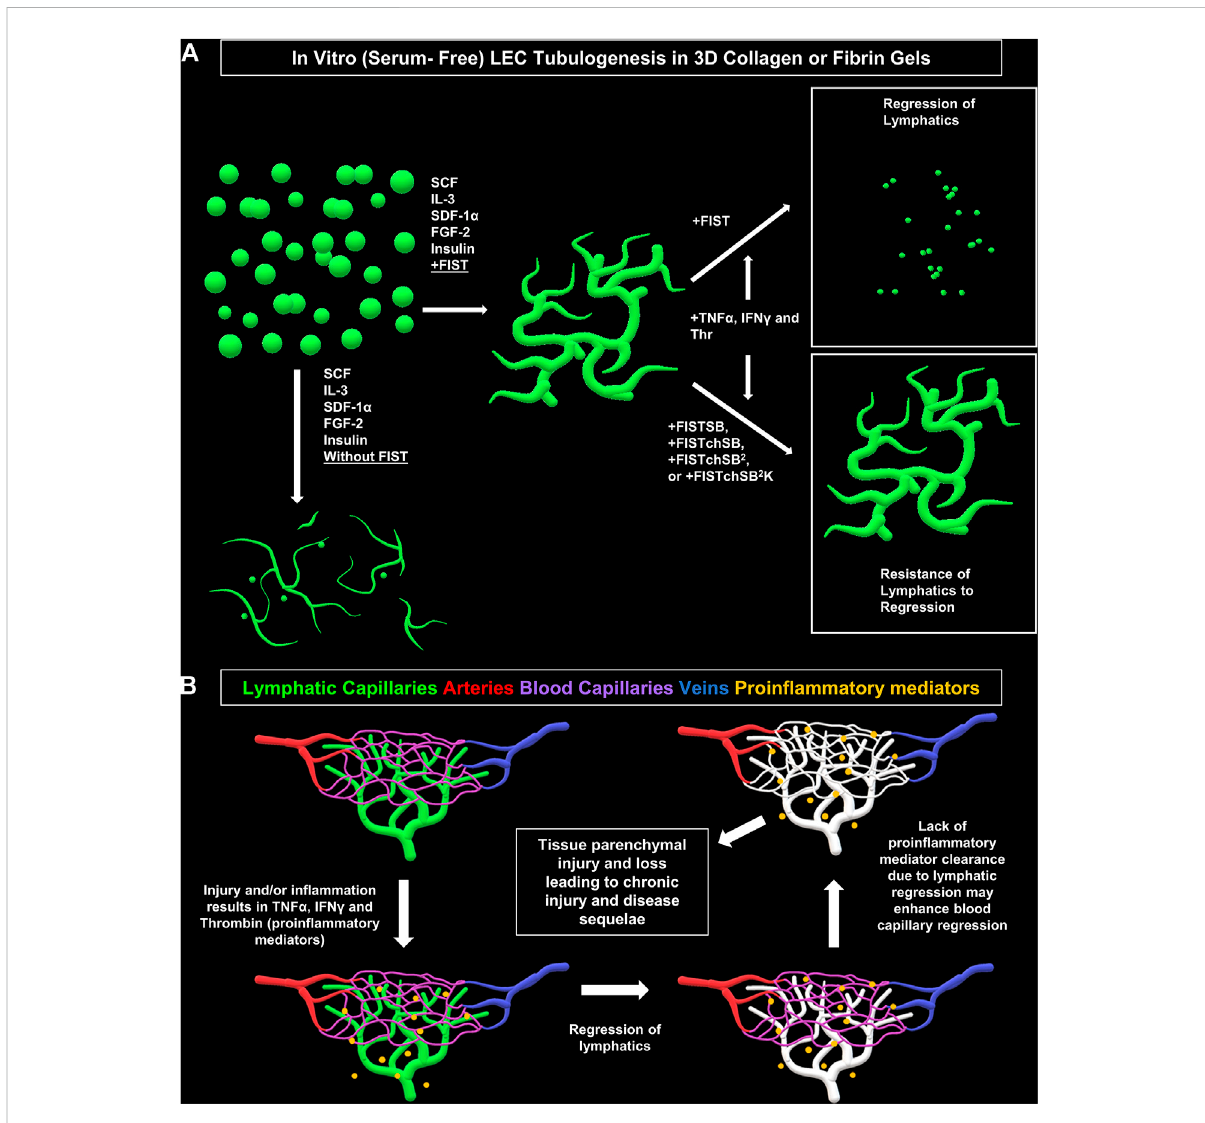
FIGURE 7 Schematic diagram illustrating formation of lymphatic EC tube network formation, proin fl ammatory mediators causing lymphatic EC capillary regression, as well as pharmacologic rescue of LEC when exposed to proin fl ammatory mediators. (A) Schematic illustration of our serum-free, fi ve growth factor system (IL [interleukin]-3, SCF [stem cell factor, SDF [stromal cell-derived factor]-1 α , FGF [ fi broblast growth factor]-2, and insulin); along with four-drug pharmacologic combination FIST (10 μ M forskolin, 100 μ M IBMX, 10 μ M SB239063, and 10 μ M Tubacin) added that induces lymphatic endothelialcells (LECs) to form tube networksin either collagen or fi brin 3Dgels. TNF (tumor necrosis factor) α , IFN (interferon) γ , andthrombincauseregressionoftheLECtubenetworksineither fi brinorcollagengels.Thiscanbeamelioratedbyadditionaldrug